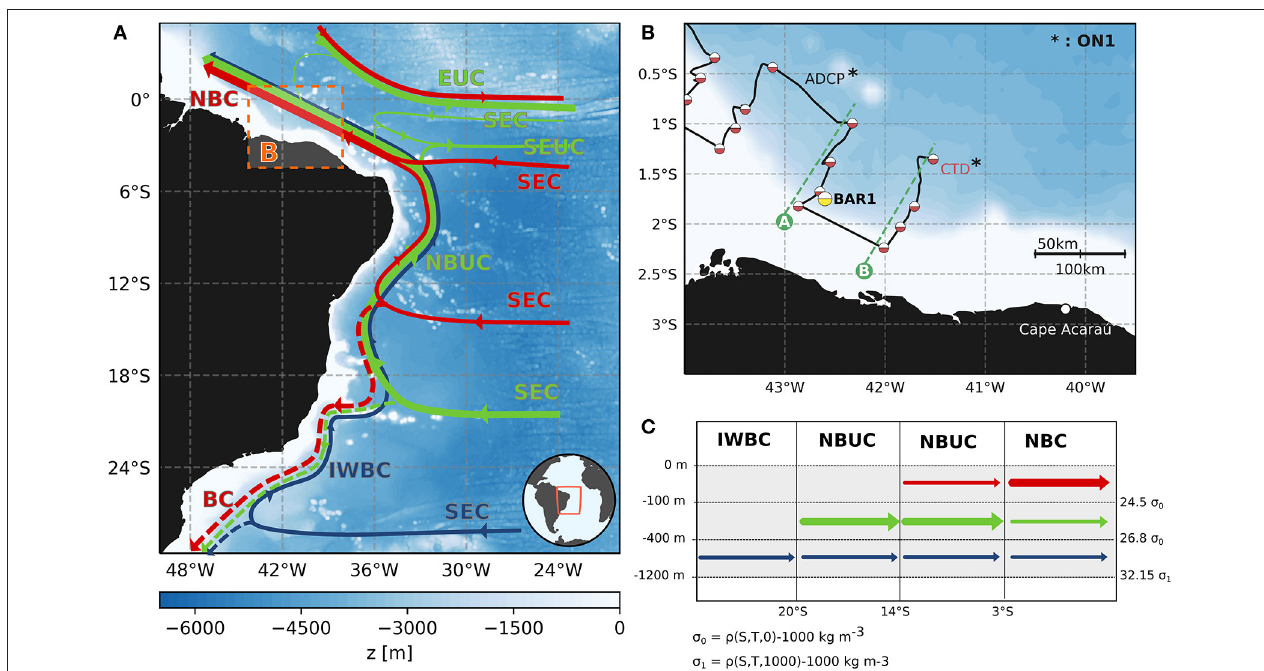
FIGURE 1 | (A) Schematic representation of the NBC organization in three different water mass domains. In red: Tropical Water (TW) from the 0m to σ 0 =24.5 kgm − 3 surface. In green: South Atlantic Central Water (SACW) from the σ 0 =24.5 to the σ 0 =26.8 kgm − 3 surfaces. In blue: Antarctic Intermediate Water (AAIW) from the σ 0 =26.8 to the σ 1 =32.15 kgm − 3 surfaces (Silveira et al., 1994; Schott et al., 1998; Soutelino et al., 2013). (B) The in situ data sets. The black line is the Brazilian Navy’s Oceano Norte I (ON1) cruise route, representing the ADCP data. The white/yellow circle represents the PETROBRAS current meter mooring location. The white/red circles depict the CTD sampling stations. The green dashed lines represent the two vertical transects analyzed in this work. (C) Vertical extent diagram of NBC formation. The arrow thickness is proportional to the volume